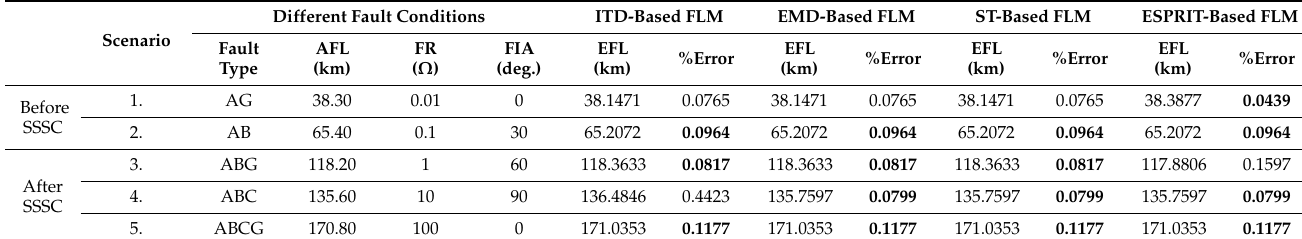
Table 1. Performance under series compensation (mid-point connected SSSC).